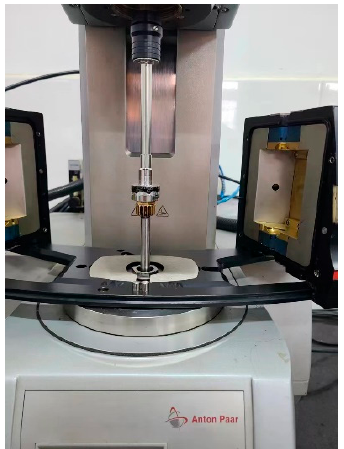
Figure 4. DSR when conducting the ru tt ing index test.